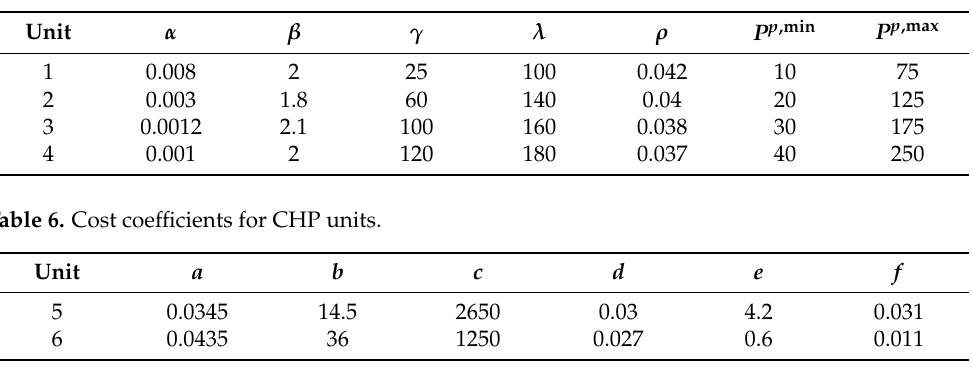
Table 5. Cost coefficients for power-only units.